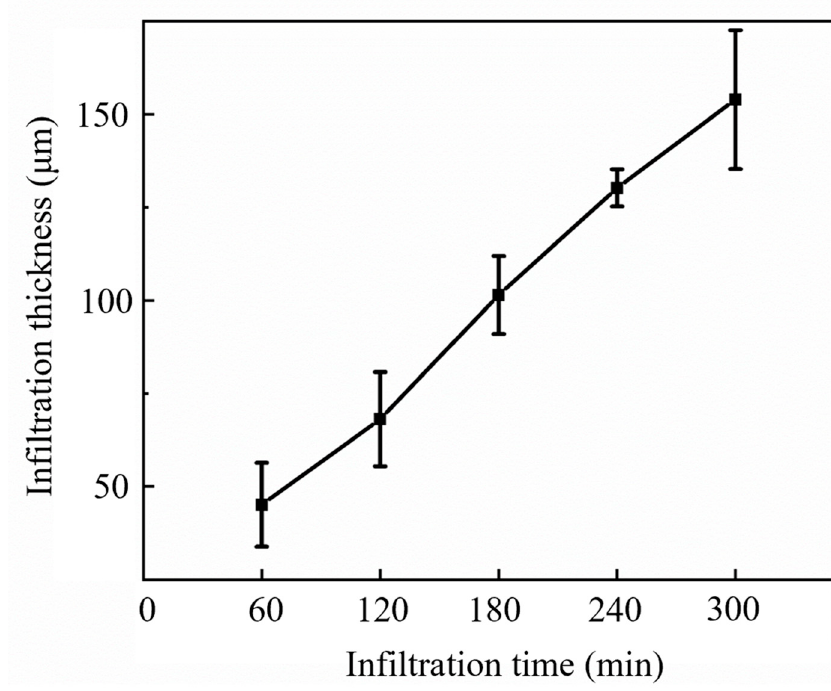
Figure 4. The infiltration thickness of composite scaffolds with infiltration time.